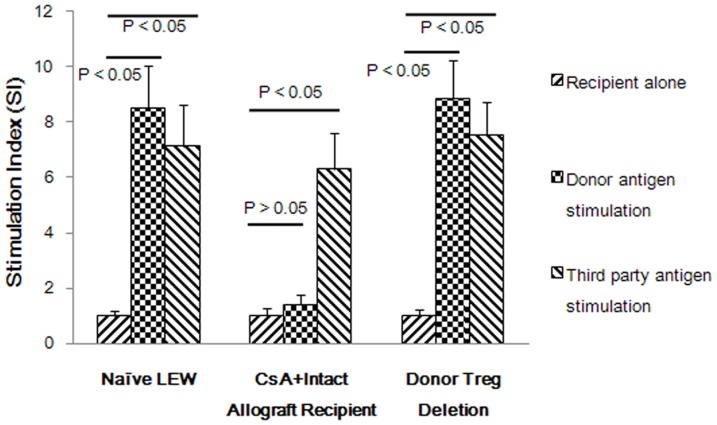
One-way MLR revealed a critical role of donor-specific FoxP3+ Tregs for the maintenance of tolerance.Baseline levels were assessed when naïve Lewis splenic cells were used as responders. Hyporeactivity to donor antigen stimulation and immunocompetence for third-party antigens stimulation (ACI rats) in recipients of group 5 at POD 100 was demonstrated. When donor-specific FoxP3+ Tregs were depleted from the responder populations, robust antidonor alloreactivity reappeared.